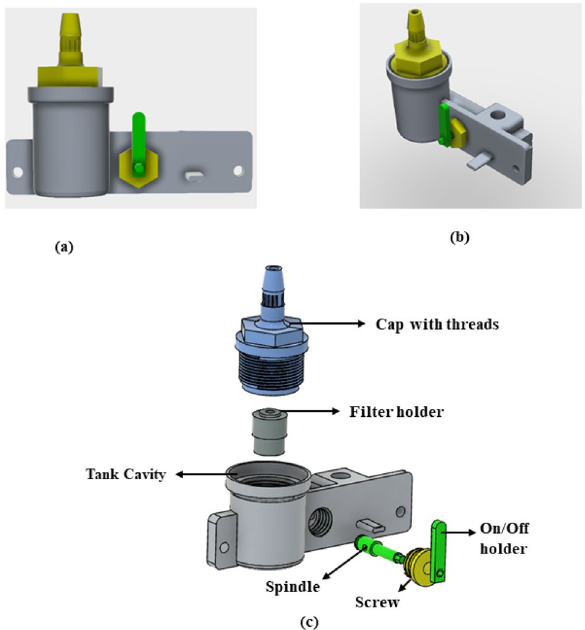
Figure 1. The Galinstan tank with the filter holder and its connection with measuring scale. ( a ) Front 3D design view. ( b ) Isometric 3D design view. ( c ) Exploded view of the full